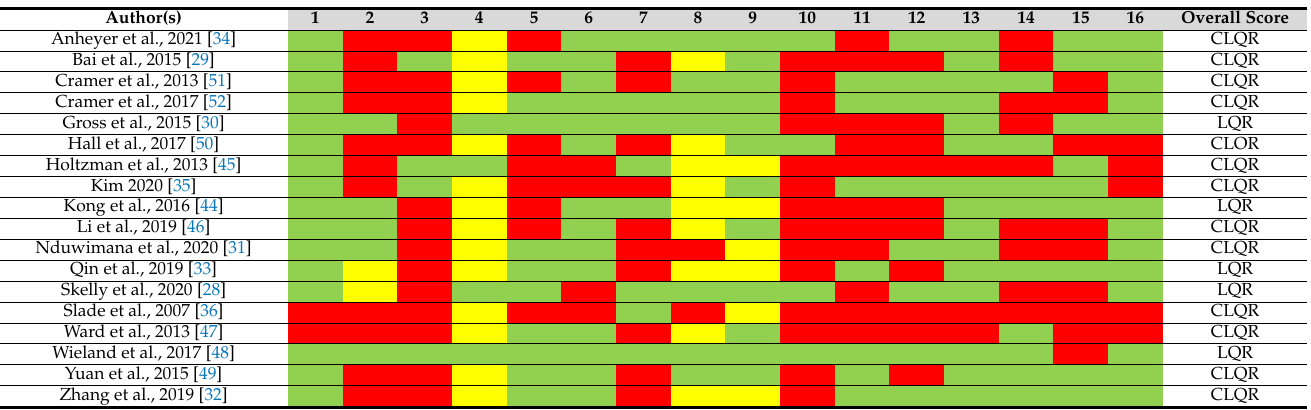
Figure 3. Density Visualization.